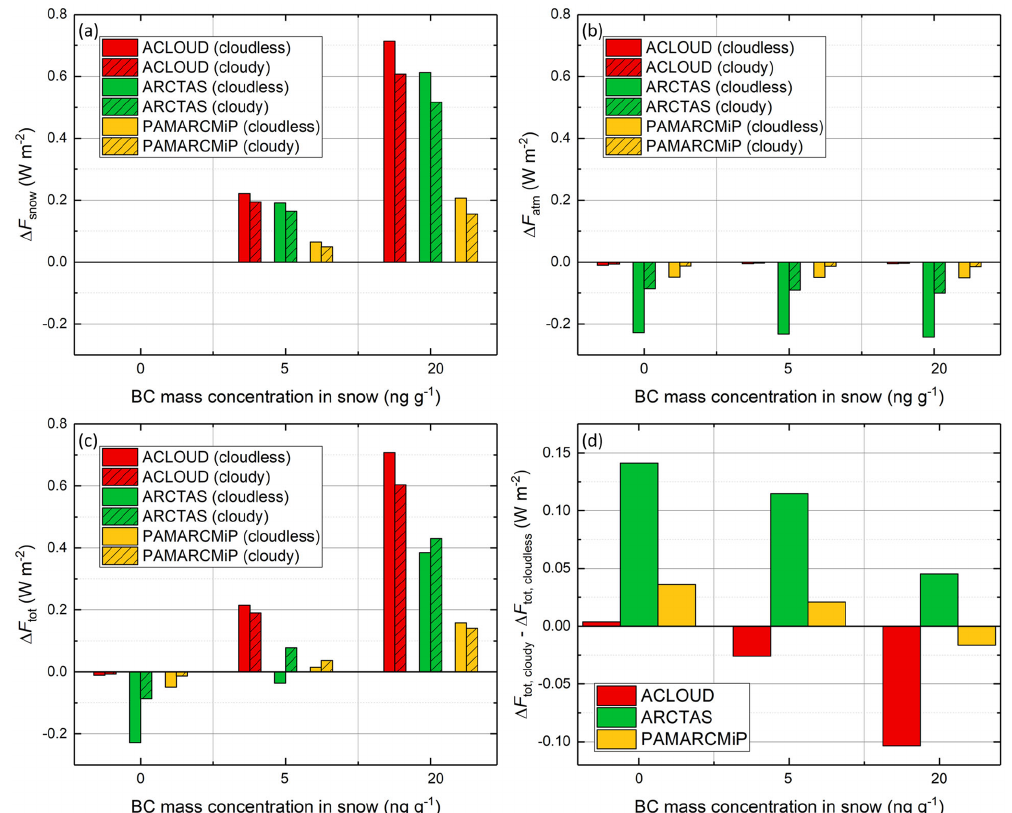
Figure 6. Daily mean of the solar surface radiative forcing simulated for the conditions of the three campaigns ACLOUD, PAMARCMiP, and ARCTAS assuming a fixed SSA of 20m 2 kg − 1 . The separated forcings by BC embedded in snow ( (cid:49)F snow , panel a ), atmospheric BC ( (cid:49)F atm , panel b ), and the total forcing ( (cid:49)F tot , panel c ) are shown. The daily mean solar radiative forcing of BC in cloudy conditions is displayed by shaded bars. The difference of (cid:49)F tot between simulations with and without clouds is given in (d)